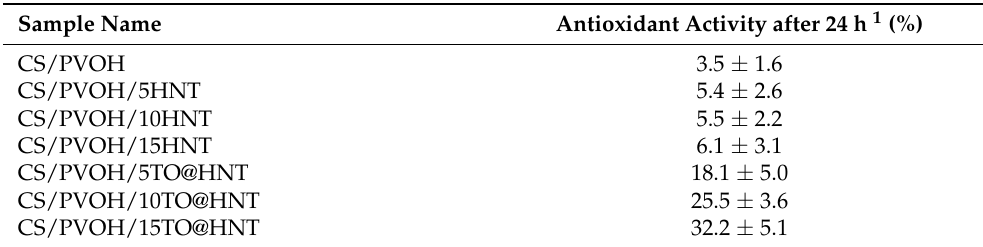
Antioxidant activity values of pure CS/PVOH and all CS/PVOH/HNT, CS/PVOH/TO@HNT films.